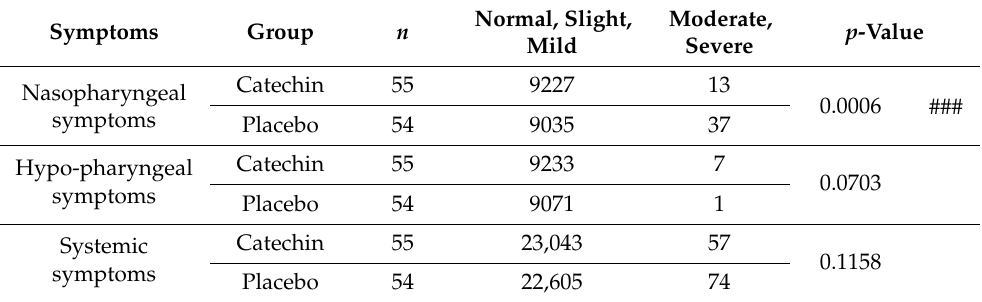
Table 6. Cumulative duration (in days) for individual sites of symptoms graded as scores of severe– moderate and mild–normal for each